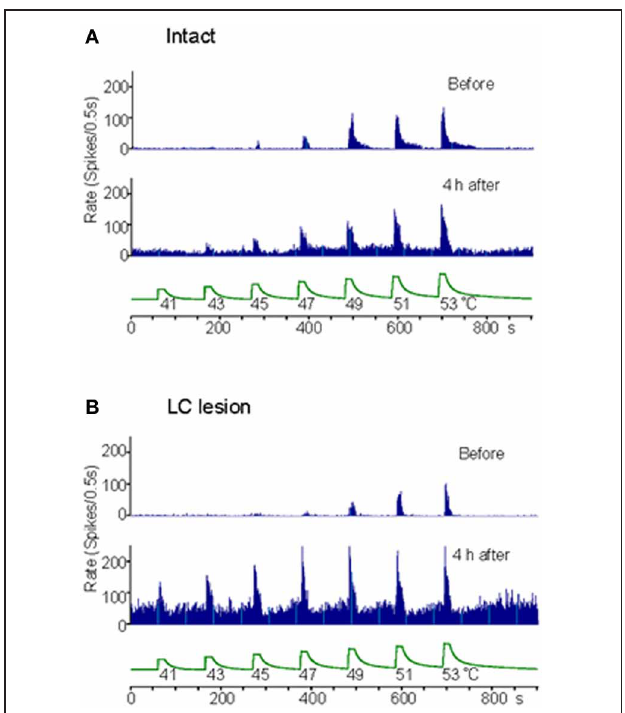
FIGURE 4 | Rate histograms for the responses to graded heat stimuli from a neuron located in the dorsal horn ipsilateral to the site of inflammation. The responses to graded heat stimuli of a neuron were tested before and 4h after the induction of inflammation. (A) Rate histograms for a neuron in a LC/SC-intact rat. (B) Rate histograms for a neuron in a LC/SC-lesioned rat (Tsuruoka et al., 2003).